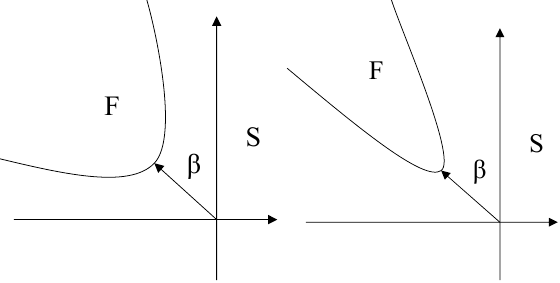
Figure 3. Regression result comparison among different models.